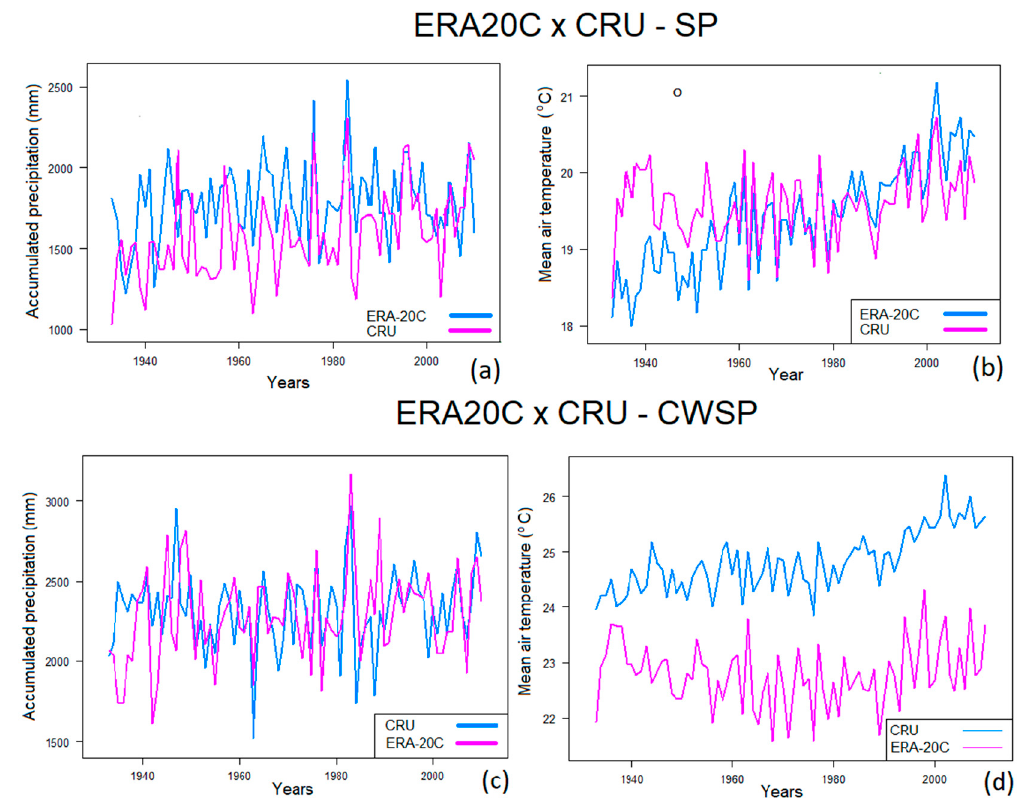
Figure 11. Time series of annual accumulated precipitation [mm] ( a , c ) and annual mean air temperature [ ◦ C] ( b , d ) from ERA20C and CRU, for the city of Sao Paulo (upper row) and for region CWSP (lower row).